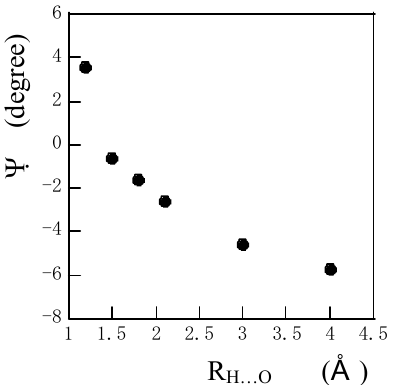
of the amide proton 33 . H…O